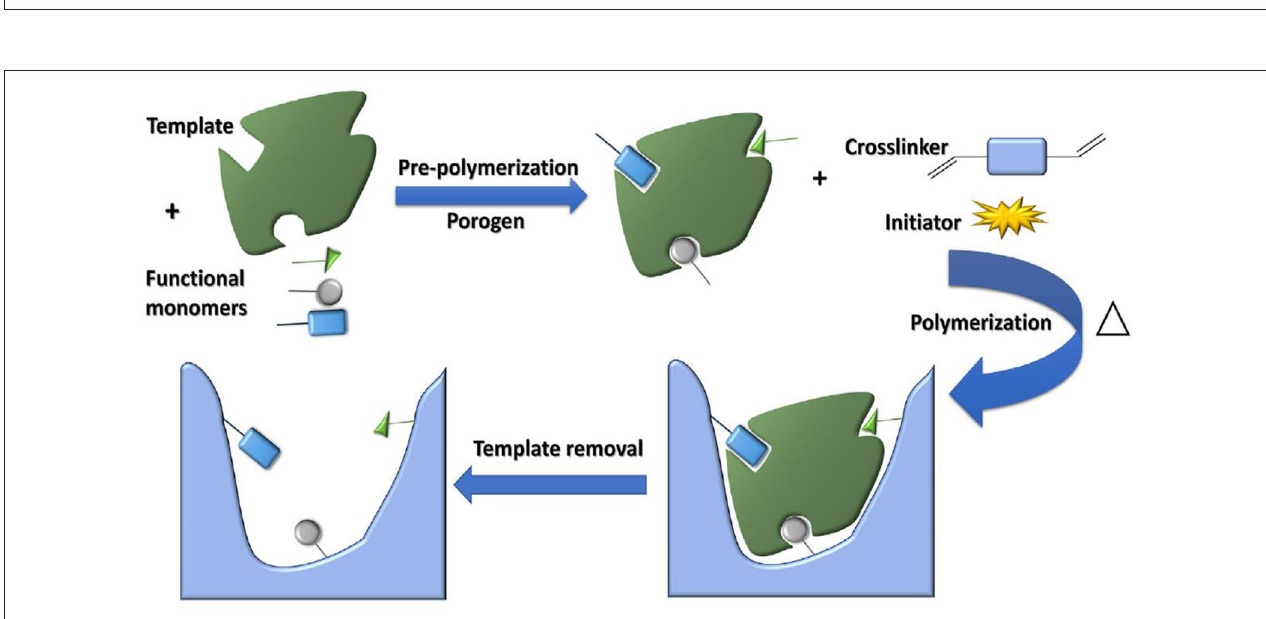
FIGURE 3 | The schematic diagram of MIPs synthesis (Azizi and Bottaro, 2020). Reprinted with permission from Elsevier. Copyright (2020)